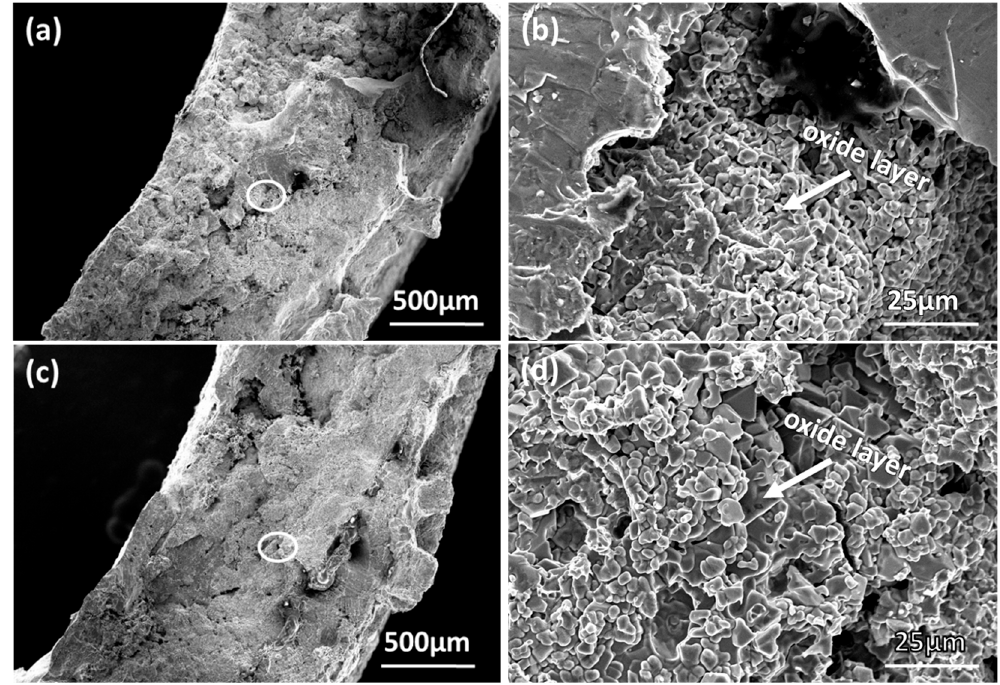
Figure 5. The fractographic appearances of the failure specimens under different T max conditions: ( a ) 800 °C and ( c ) 900 °C. ( b ) and ( d ) are the magnified images of the parts outlined by circles in ( a ) and ( c ).